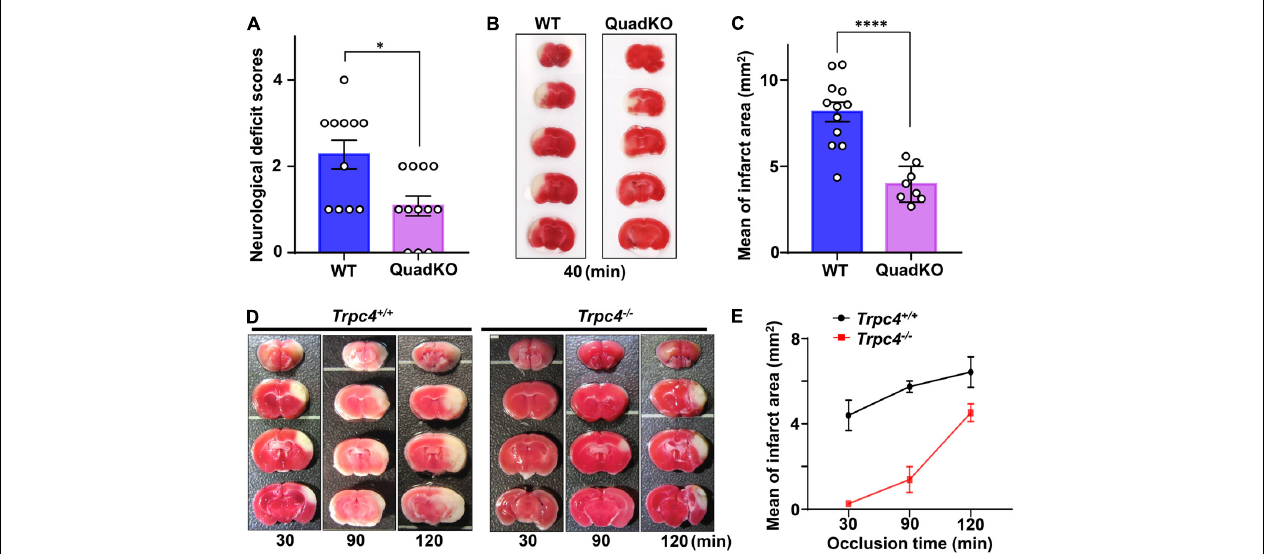
FIGURE 2 | Transient receptor potential canonical (TRPC) deficiency attenuates cerebral ischemic damage. (A–C) TRPC1, C4, C5, C6 quadruple knockout (QuadKO) and wild type control mice were subjected to reversible MCAO for 40 min using intraluminal suture method, followed by 22–24 h reperfusion. After assessing neurological deficits as described (Li et al., 2011) (A) , the animals were sacrificed and brain sections stained with TTC for quantification of infarct areas (B,C) . (A) Neurological scores of animals subjected to ischemia/reperfusion. Data represent means ± SEM for n = 11 (wild type) and 12 (QuadKO) mice. ∗ P < 0.05 by Mann–Whitney test. (B) Representative photographs of TTC-stained brain sections demarcating infarction. (C) Infarct areas at rostrocaudal plains were determined from morphometric analyses of TTC-stained brain sections. Data represent means ± SEM for n = 12 (wild type) and 8 (QuadKO) mice. ∗∗∗∗ P < 0.0001 by unpaired t -test. (D,E) Trpc4 − / − and wild type control mice were subjected to reversible 30, 90, and 120 min MCA/CCAO, followed by 24 h reperfusion. (D) Representative photographs of TTC-stained brain sections. (E) Infarct areas at rostrocaudal plains were determined from morphometric analyses of TTC-stained brain sections. Data are presented as means ± range for n = 2 mice for each time